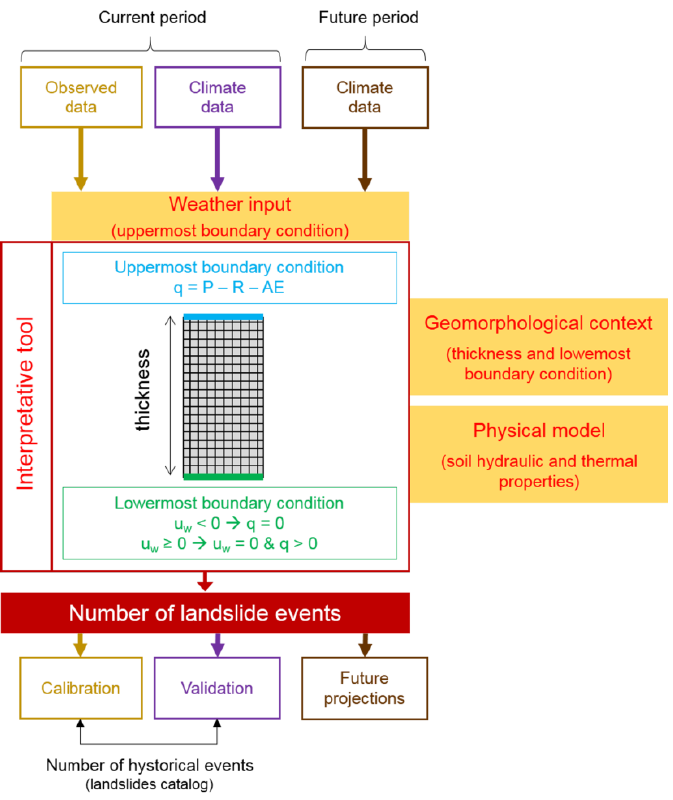
Figure 3. conceptual framework for evaluation of potential effects of CC on landslide occurrence. Figure 3. Conceptual framework for evaluation of potential effects of CC on landslide